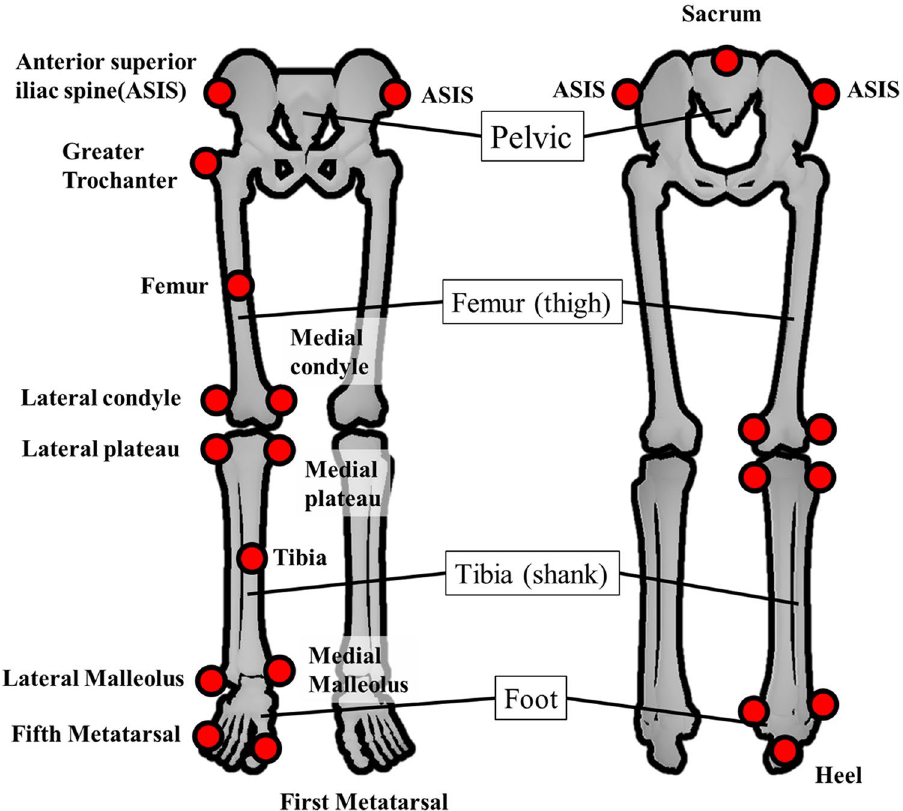
Figure 3. Lower extremity markers configuration: anatomical site of the marker